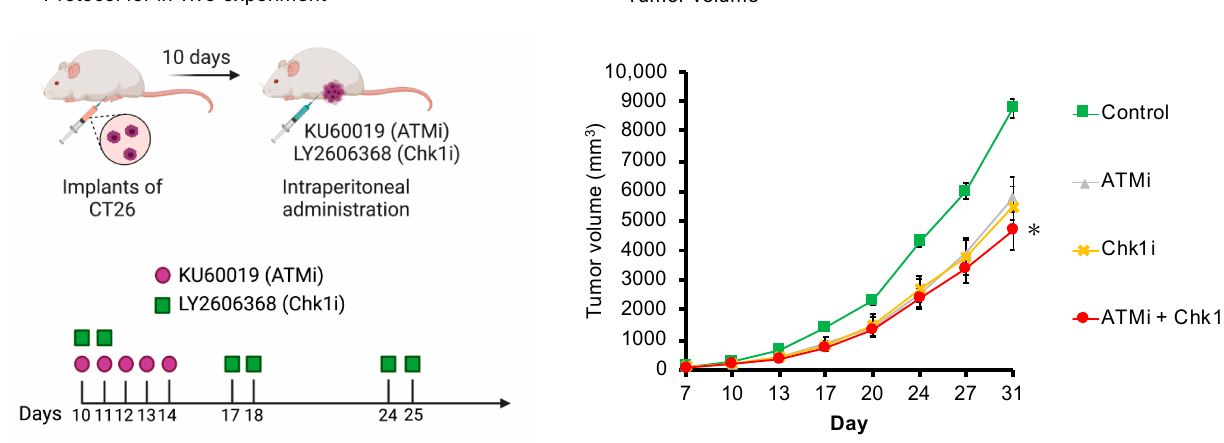
Figure 5. Effect of the combined ATMi and Chk1i treatment on syngeneic tumor model mice. ( A ) Protocol for the analysis of the effect of the combined ATMi and Chk1i treatment on syngeneic tumor model mice. CT26 cells were implanted subcutaneously. ( B ) Tumor volume of the control, ATMi, Chk1i, and ATMi + Chk1i groups was monitored for 31 days. Data are presented as mean ± SE (control group: n = 5, ATMi group: n = 7, Chk1i group: n = 3, ATMi + Chk1i group: n = 4; * p <